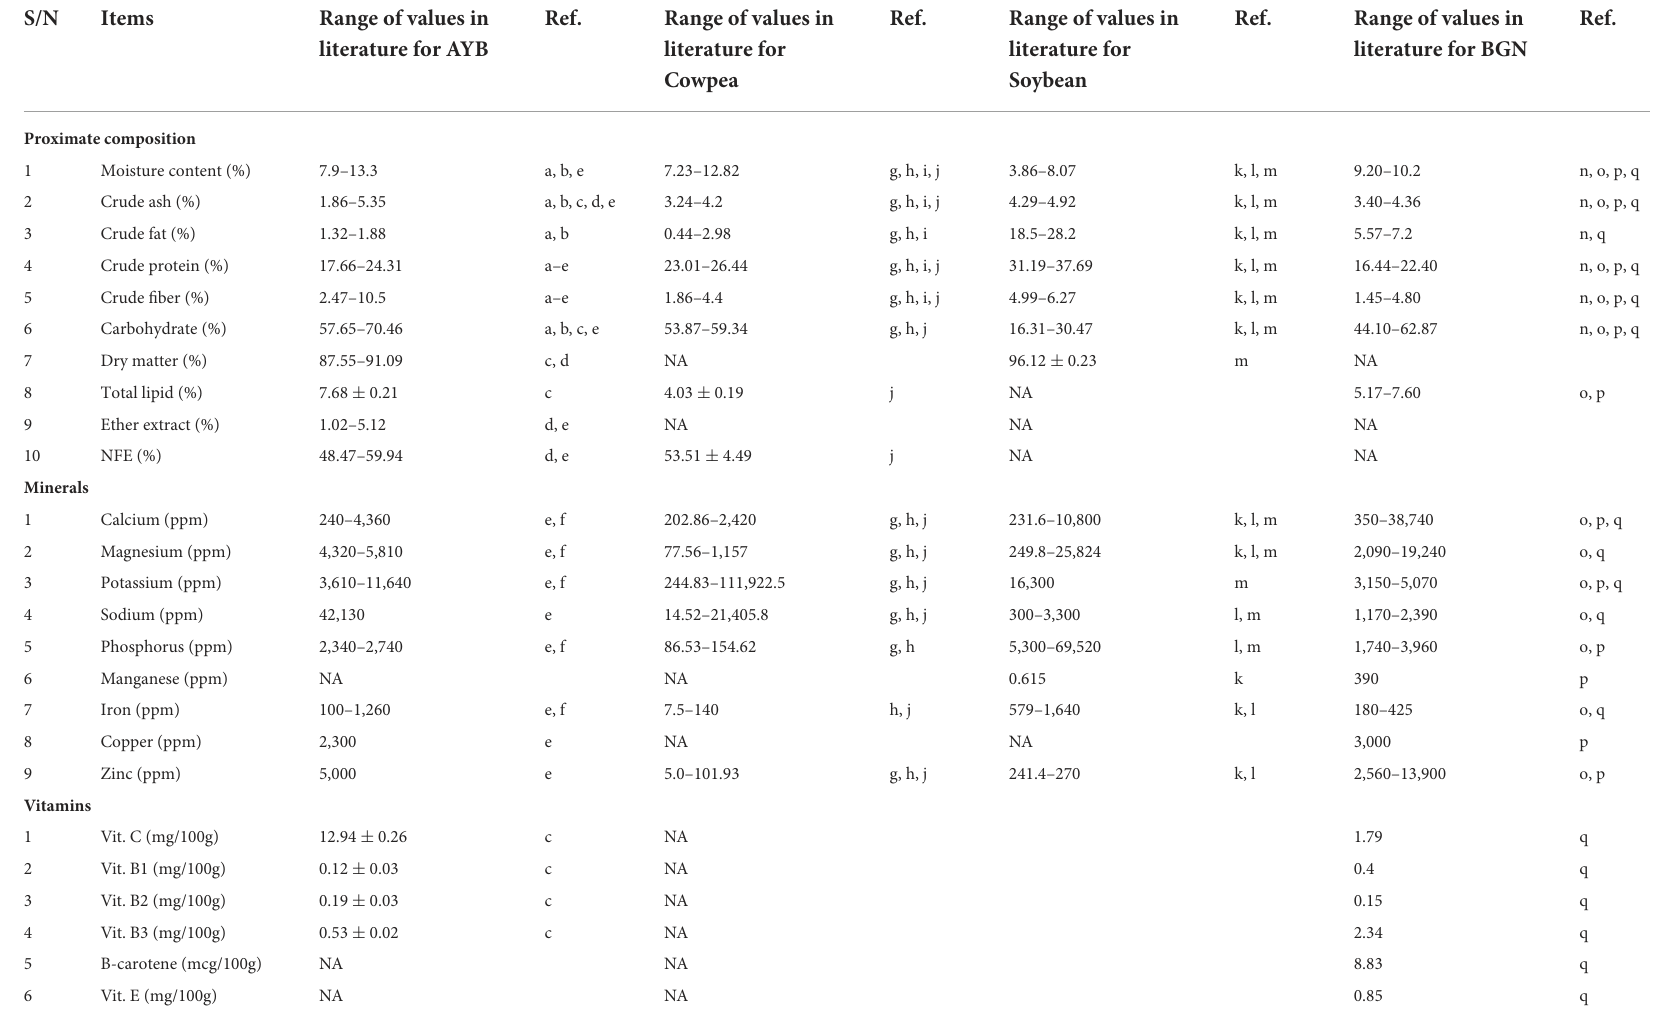
TABLE 4 Ranges in proximate, mineral and vitamin contents on dry matter basis in the seed of African yam bean, cowpea, soybean and bambara ground nut as revealed in literature. S/N Items Range of values in Ref. Range of values literature for AYB